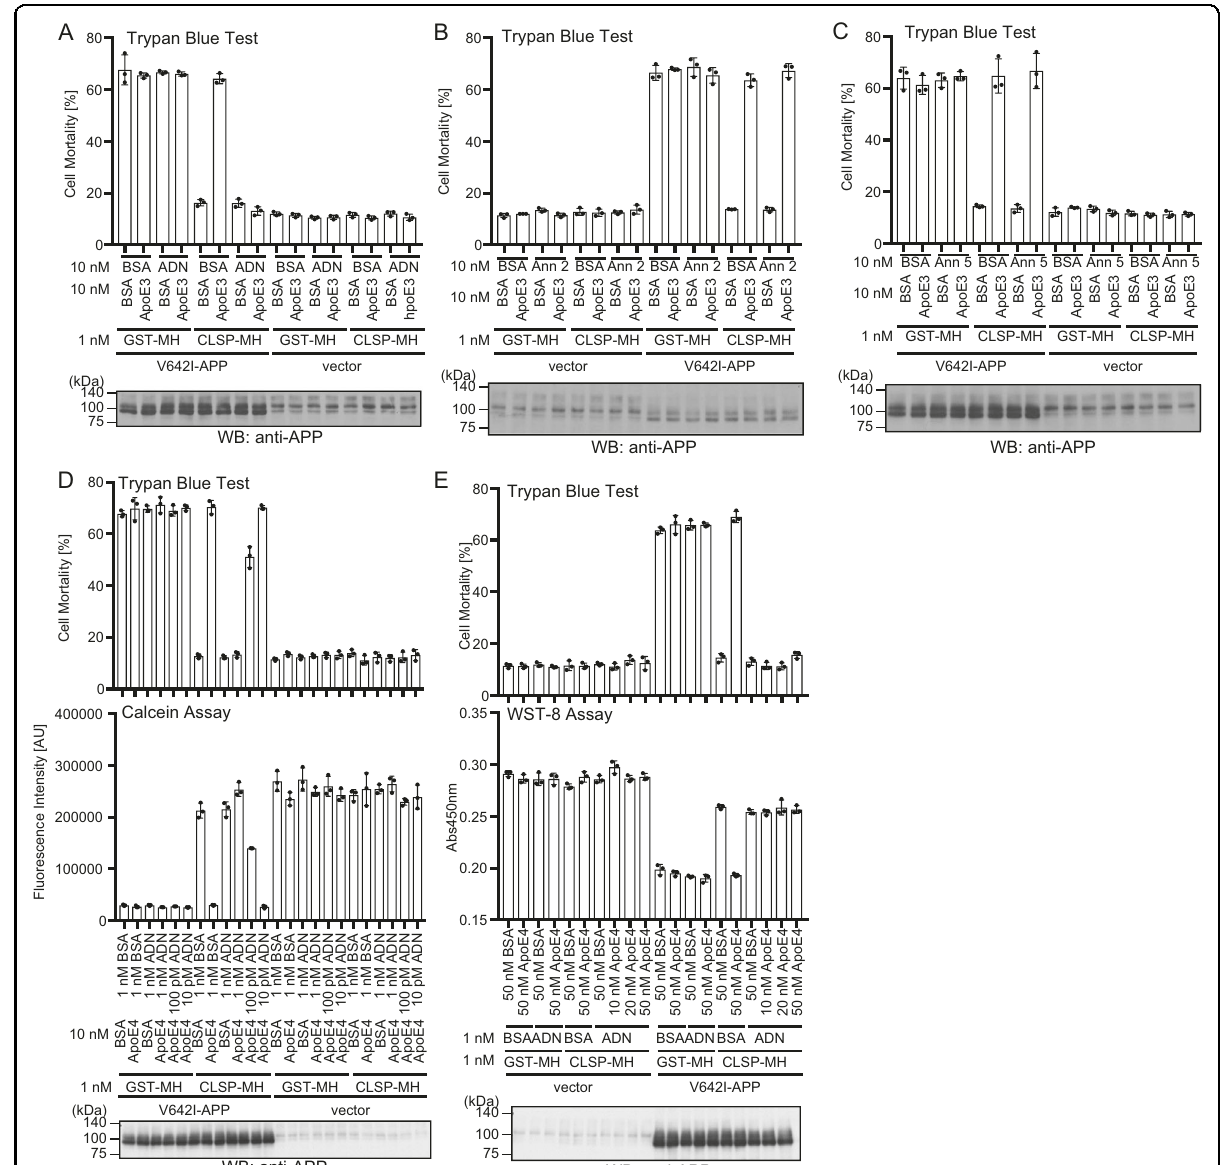
Fig. 2 Adiponectin enables CLSP to be active in the presence of higher concentrations of apolipoprotein E4. a – c SH-SY5Y cells, transfected with the empty vector or pcDNA3.1/MycHis-V642I-APP, were cultured in media containing 1 nM of GST-MycHis or CLSP-MycHis with 10 nM of ApoE3 or BSA with 10 nM of adiponectin (ADN) (a), annexin 2 (b), annexin 5(c), or BSA. GST-MycHis and BSA were used as negative controls. At 48 h, cells were harvested for trypan blue exclusion assays. d SH-SY5Y cells, transfected with the vector or pcDNA3.1/MycHis-V642I-APP, were cultured in media containing 1 nM of GST-MycHis or CLSP-MycHis with/without 10nM of ApoE4 with/without indicated concentrations of adiponectin (ADN). At 48h, the cells were harvested for the trypan blue exclusion and calcein assays. e SH-SY5Y cells, transfected with the vector or pcDNA3.1/MycHis-V642I-APP, were cultured in media containing 1 nM of GST-MycHis or CLSP-MycHis with/without stepwise increasing concentrations of ApoE4 with/without 1 nM of ADN. At 48h, the cells were harvested for trypan blue exclusion and WST-8 assays. The cell lysates were immunoblotted using the APP